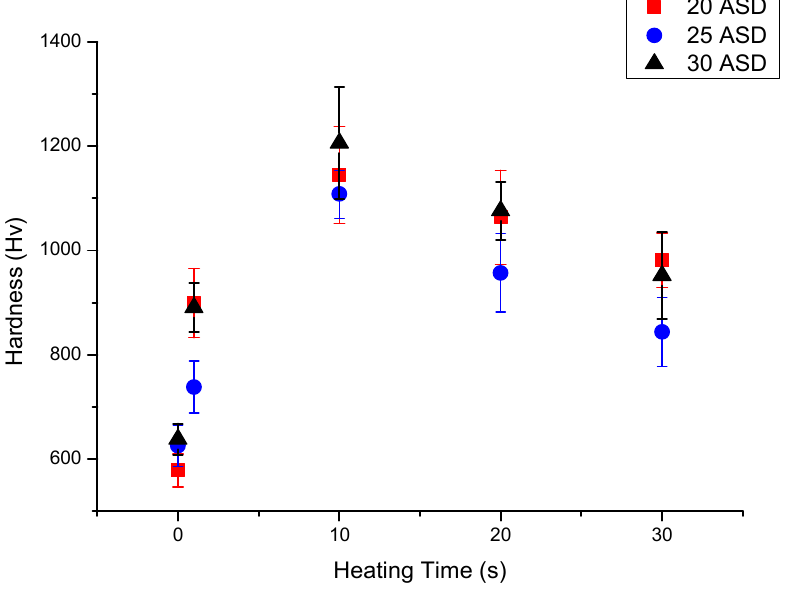
Figure 3. Hardness variation of Cr-Fe-C alloy deposits after rapid thermal annealing (RTA) at 500 °C from 1 to 30 s.